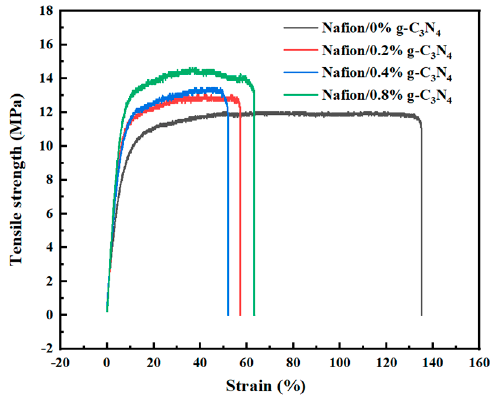
Figure 8. Stress − strain curves for the Na fi on/g − C 3 N 4 modified membranes.